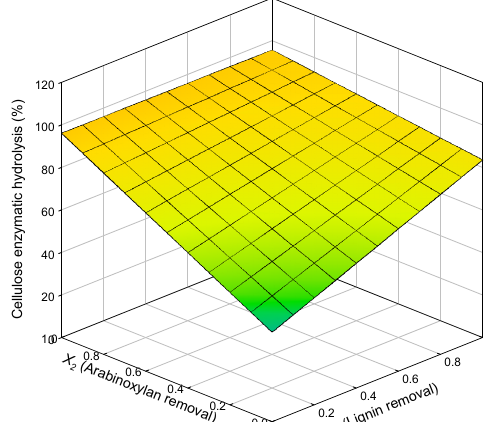
Figure 3. Response surface for cellulose enzymatic hydrolysis in relation to lignin removal (X 1 ) and arabinoxylan removal (X 2 ).